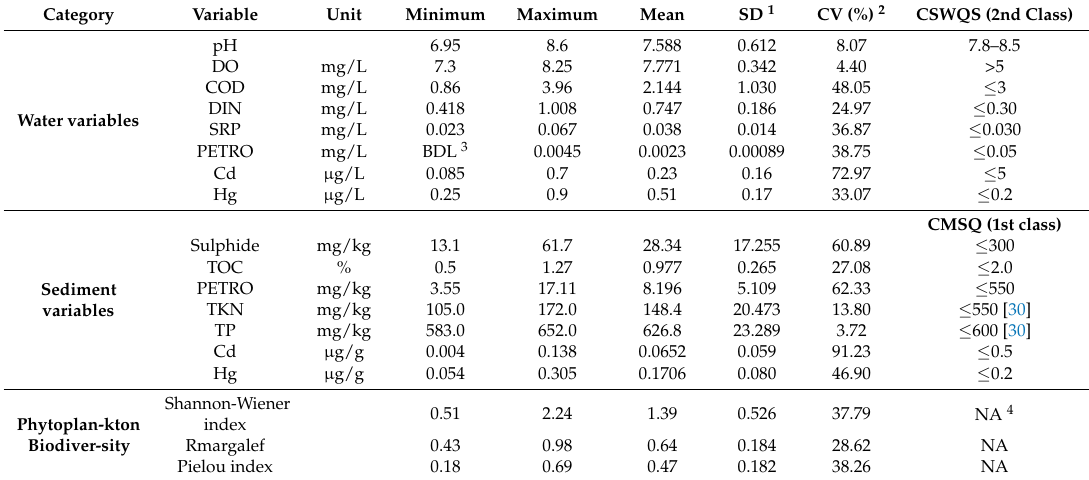
Phytoplan-kton Biodiver-sity